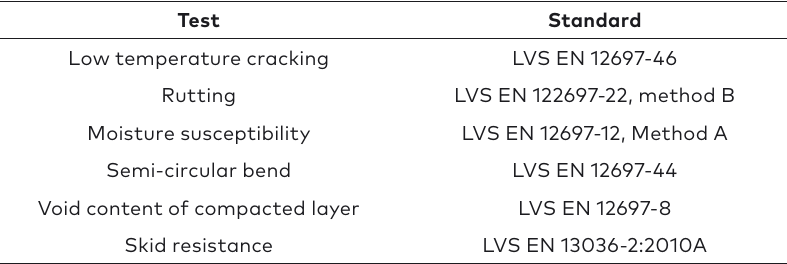
Table 9. Performance tests conducted on the plant produced specimens